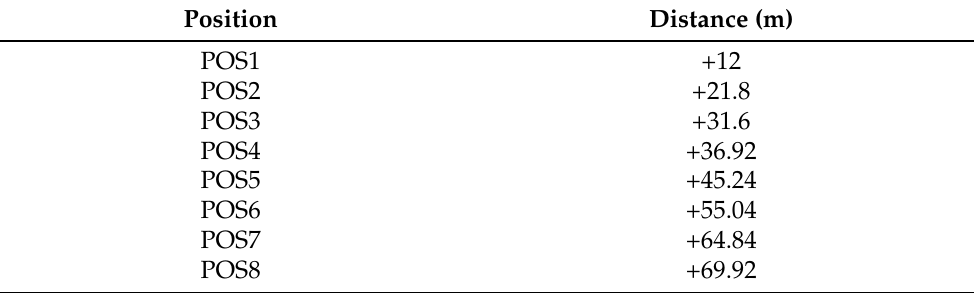
Table 6. Positions inside the ELICAN prototype.